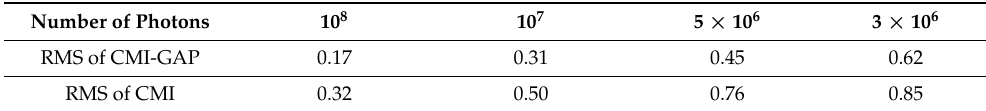
Figure 8. Reconstruction of the USAF given near-field CMI experimental data at varying illumination photons. The reconstruction from the CMI-GAP algorithm has fewer artifacts and a higher resolution. Table 1. RMS corresponding to the near-field CMI.